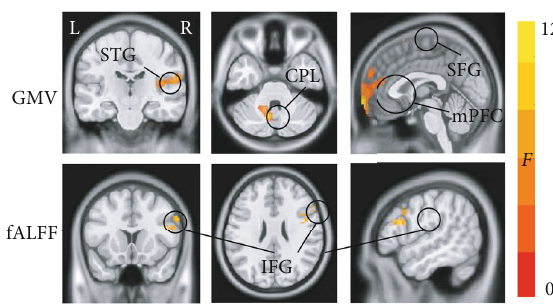
Figure 2: The regions showing signi fi cant di ff erences in GMV/fALFF values among the PSND, PSD, and NC groups. GMV: gray matter volume; fALFF: fractional amplitude of low-frequency fl uctuation; STG: superior temporal gyrus; CPL: cerebellum posterior lobe; SFG: superior frontal gyrus; mPFC: medial prefrontal cortex; IFG: inferior frontal gyrus; L: left; R: right. Color bar represents F